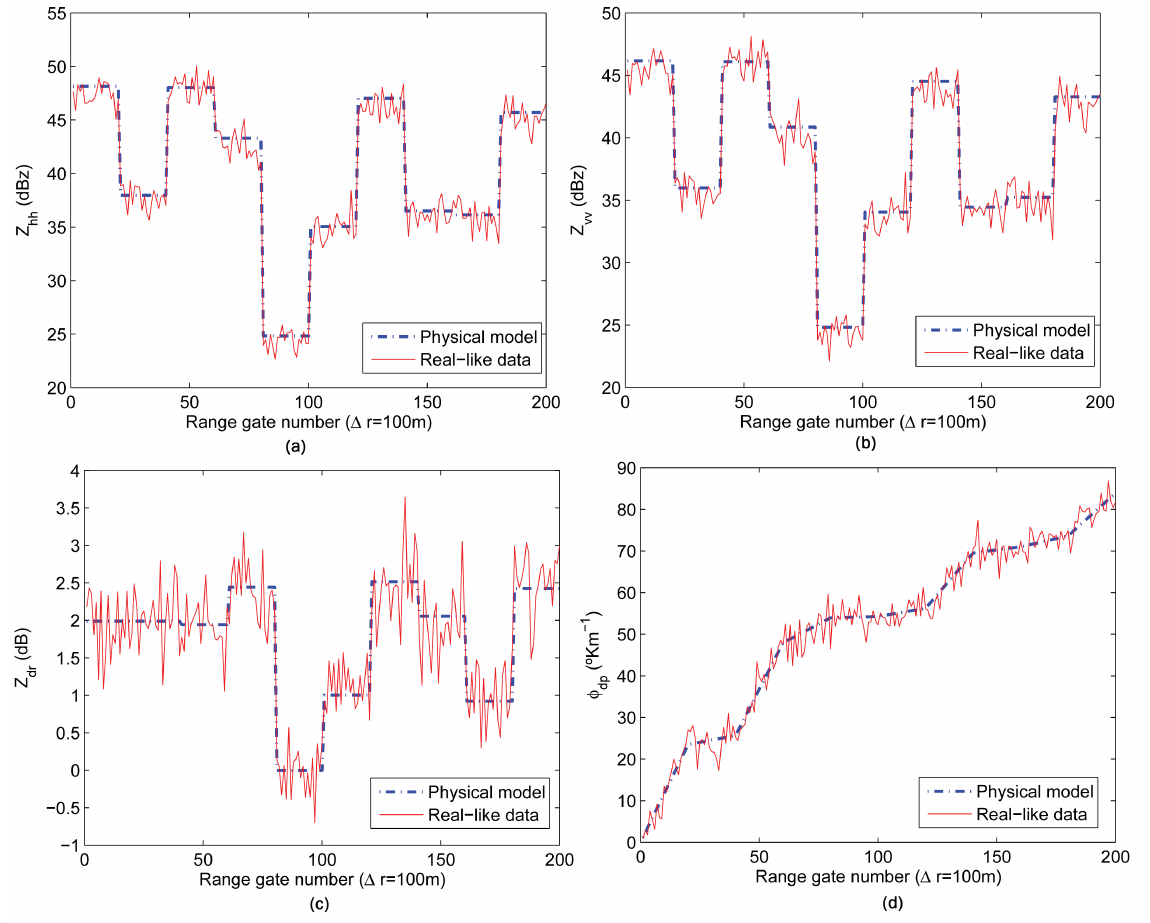
Fig. 3. Example of the generated data (a) horizontal reflectivity (b) vertical reflectivity (c) the differential reflectivity (d) differential phase